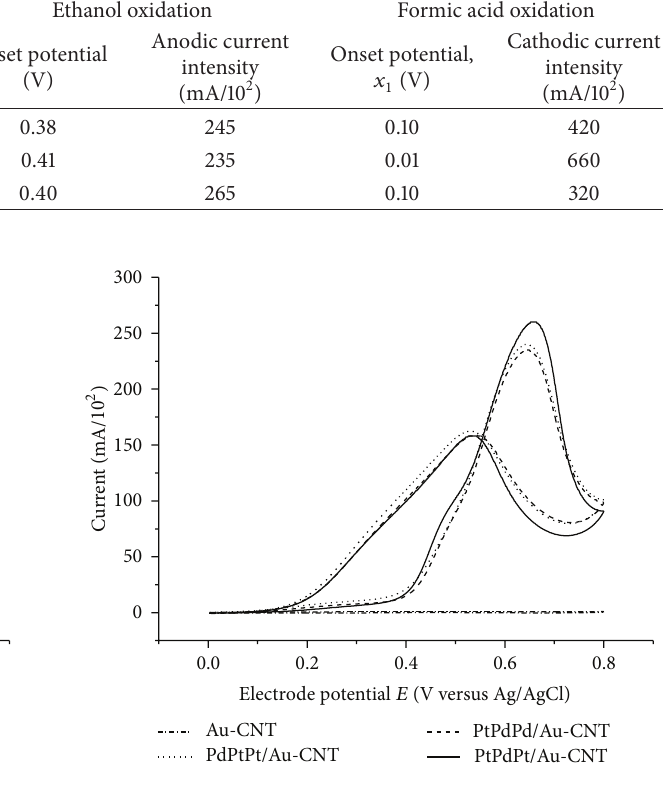
Figure 2: Cyclic voltammograms recorded in 2 MCH 3 OH + 1MH 2 SO 4 solution at Au-CNT, PdPtPt/Au-CNT, PtPdPd/Au-CNT, and PtPdPt/Au-CNT in the potential range 0.00 to 0.80 V at a scan rate 0.05 V ⋅ s −1 .